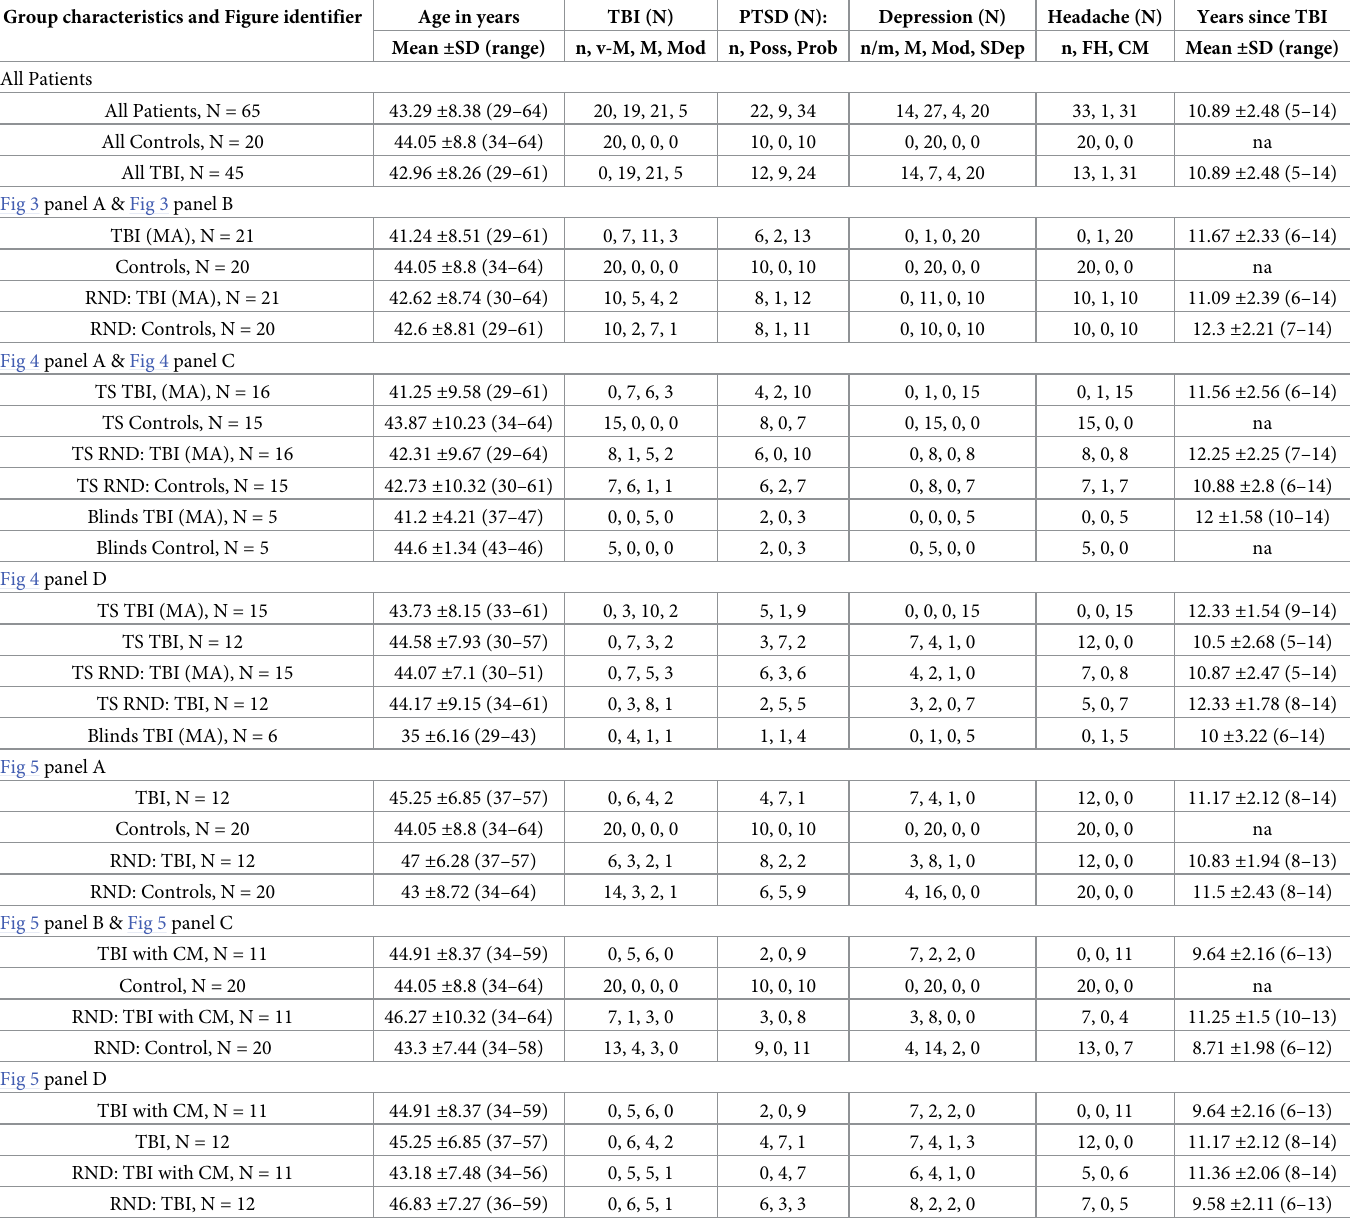
Table 1. Patient